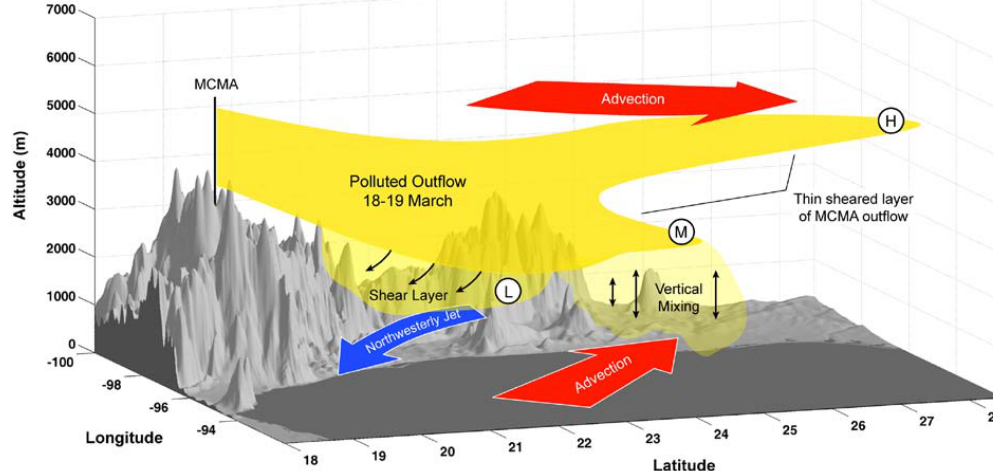
Fig. 16. Cartoon summarizing the main features of the long-range transport of MCMA pollution on 18–19 March. These include the northwesterly jet that sheared the lower portions of the outflow to the east, the advection that likely caused the extensive mixing of the lower portion of the outflow over the Gulf of Mexico, and shear-induced layer formation at higher altitudes. The three long-range C-130 intercepts are designated by the circle symbols (L=low-level intercept, M=mid-level intercept, and H=high-altitude intercept).